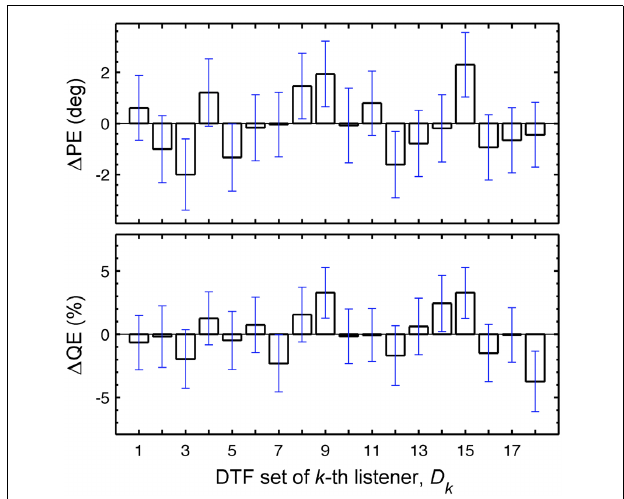
FIGURE 6 | Listener-specific performance depends on the DTF set used in the model. (cid:2) PEs and (cid:2) QEs averaged over all U k s as a function of D k . (cid:2) PEs and (cid:2) QEs are the PEs and QEs relative to the listener-specific PEs and QEs, respectively. The whiskers show ± 1